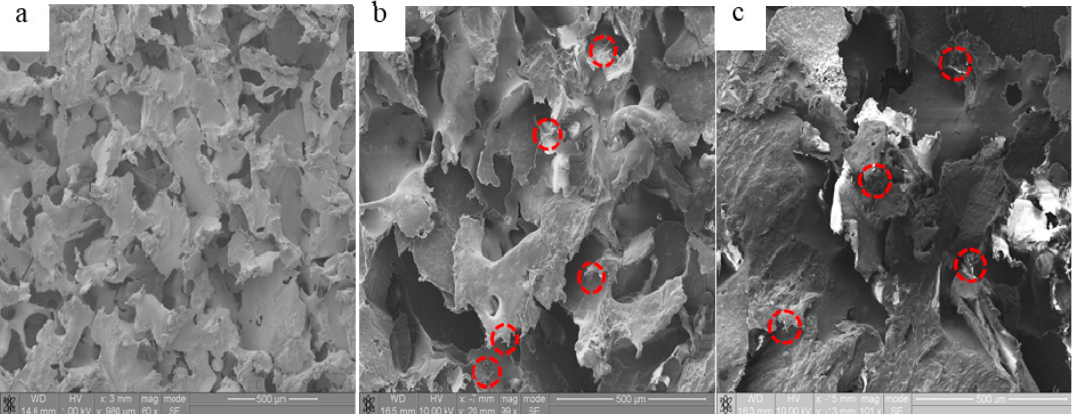
Figure 1. SEM micrographs of bionanocomposites with 75% porosity: ( a ) PEEK only, ( b ) PEEK/HA (20 wt%)/CNTs (0.5 wt%), and ( c ) PEEK/HA (20 wt%)/CF (0.5 wt%).